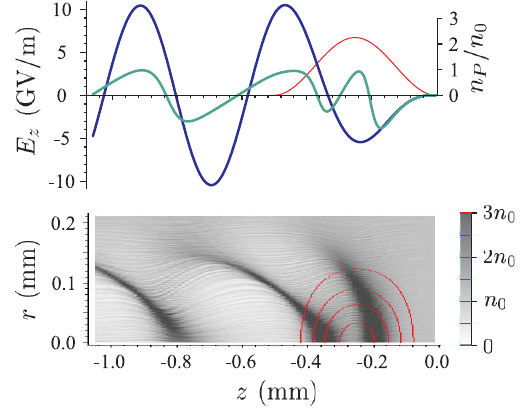
FIG. 1. (Color) Wakefield of the Gaussian beam for the ‘‘linear optimum’’ plasma density of 5 : 6 (cid:2) 10 15 cm (cid:1) 3 . On-axis electric field (top): actual (green) and predicted by the linear theory (blue); thin red line shows the on-axis driver density. Density of plasma electrons (bottom); red lines show the driver density.